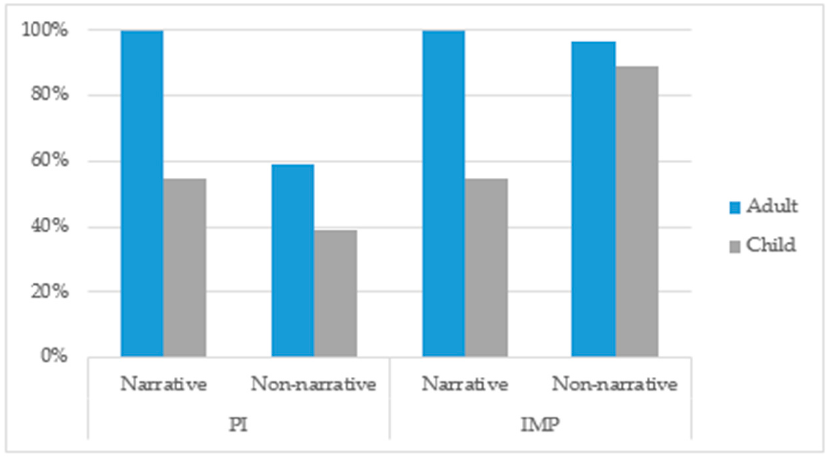
Figure 7. Proportion of target responses per age group and experimental setting for the C–O